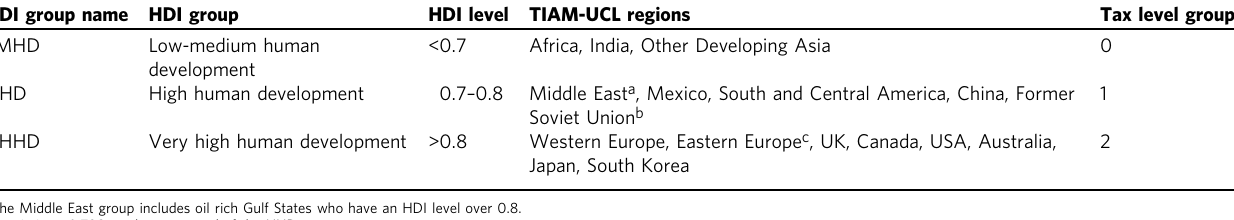
Table 1 HDI criteria groups and their composition based on regions in